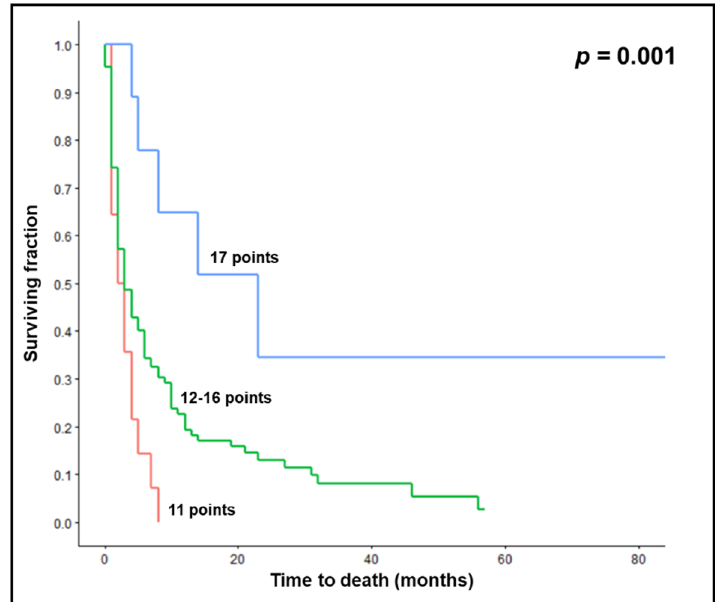
Figure 7. Model 3: Kaplan-Meier curves for survival of the three groups (11, 12–16 and 17 points).